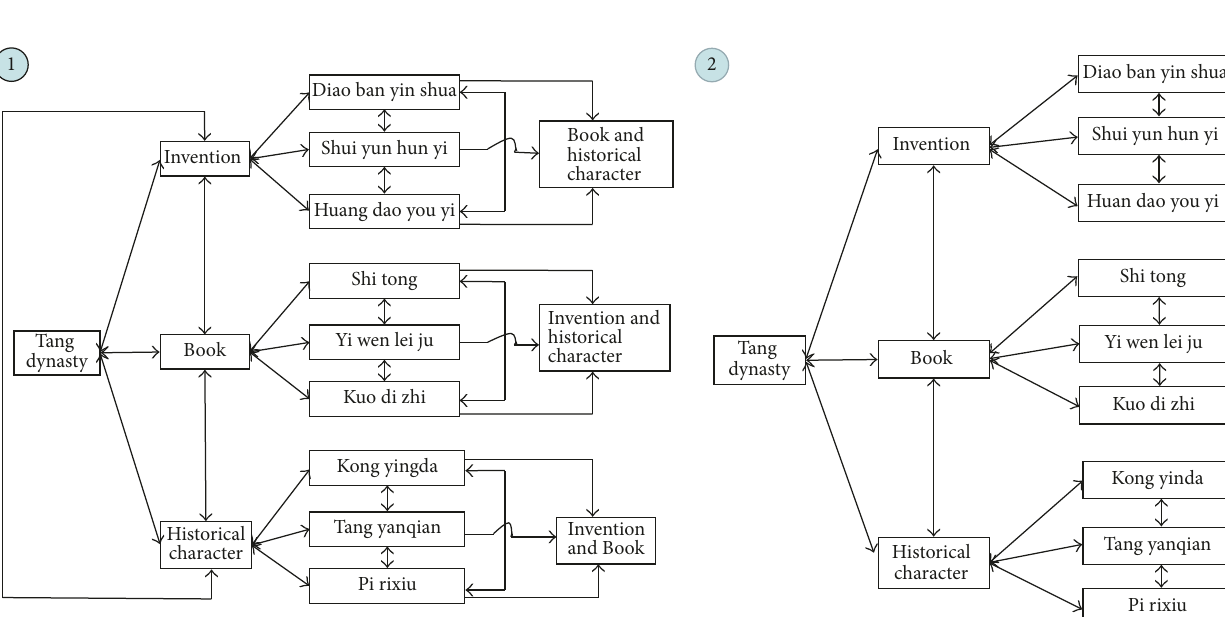
Figure 4: An example of two different path diagrams (the segment with one arrow means one-way relationship, which means node A can reach node B while node B cannot reach node A; the segment with two arrows means that node A and node B can reach each